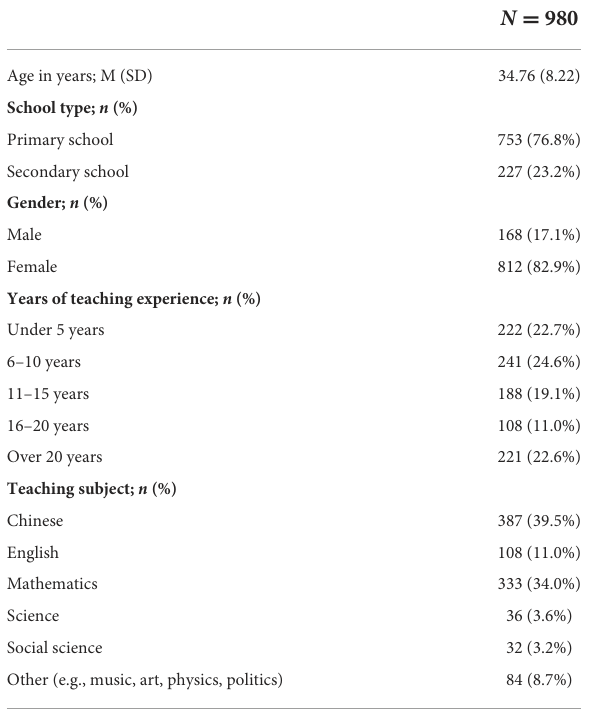
TABLE 1 Characteristics of